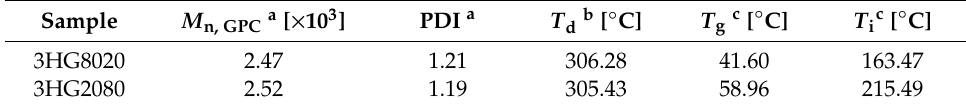
Table 1. The characterization data of the side-chain liquid crystal co-polymers (SCLCPs).